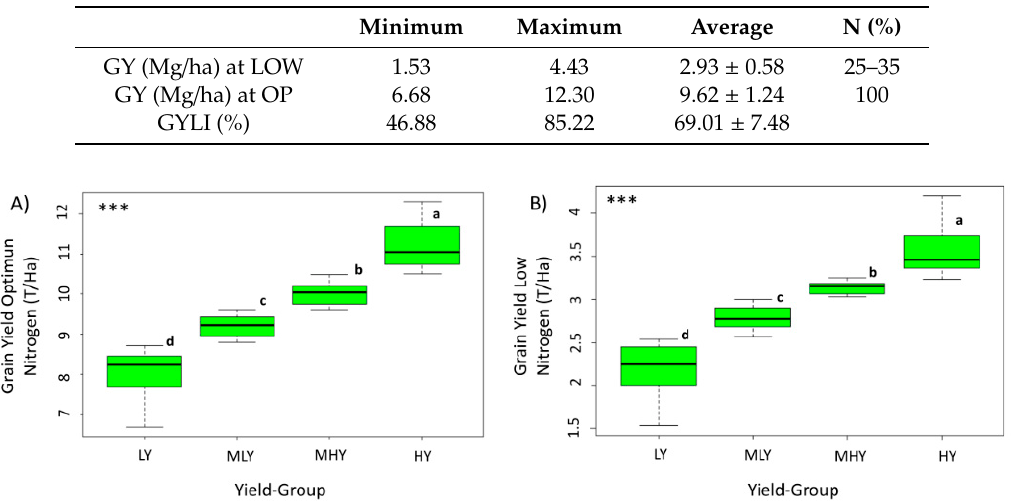
Figure 4. Box plot of grain yield for the set of 64 genotypes divided into four quartiles: low yield (LY), medium low yield (MLY), medium high yield (MHY), and high yield (HY) under OP ( A ) and LOW ( B ) conditions. The bottom and top of the box are lower and upper quartiles, respectively. The band near the middle is the median value across each group, and the bars are the standard deviation. Letters are significantly different according to Fisher Least Significant Difference (LSD) multiple range test ( P < 0.01).